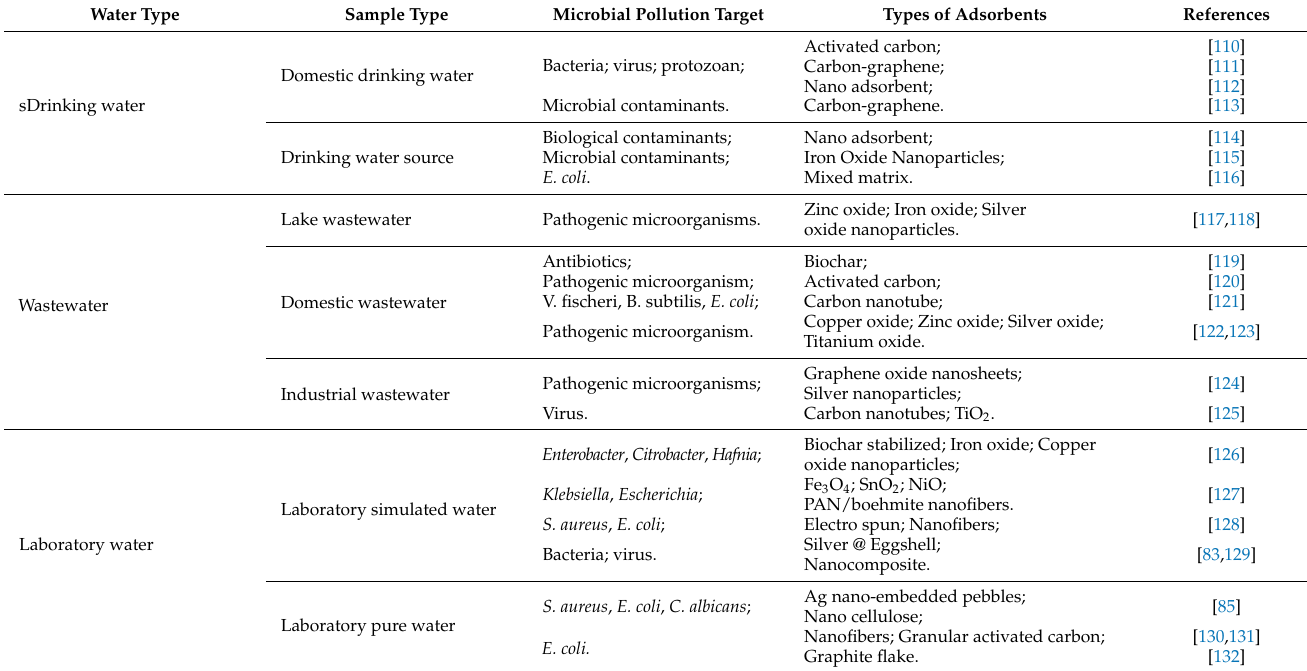
Table 2. Various kinds of adsorbents for microbial removal in different water